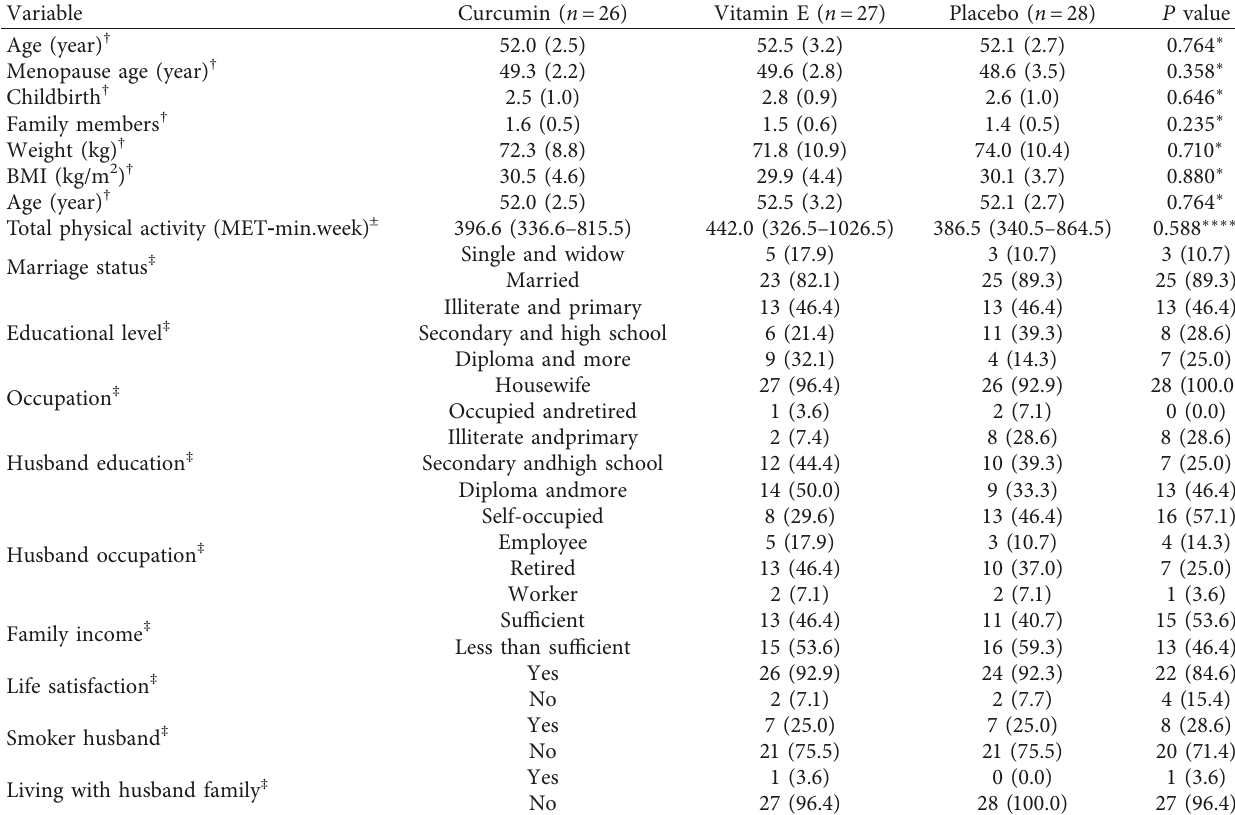
Table 1: Baseline characteristics of participants among the study groups.